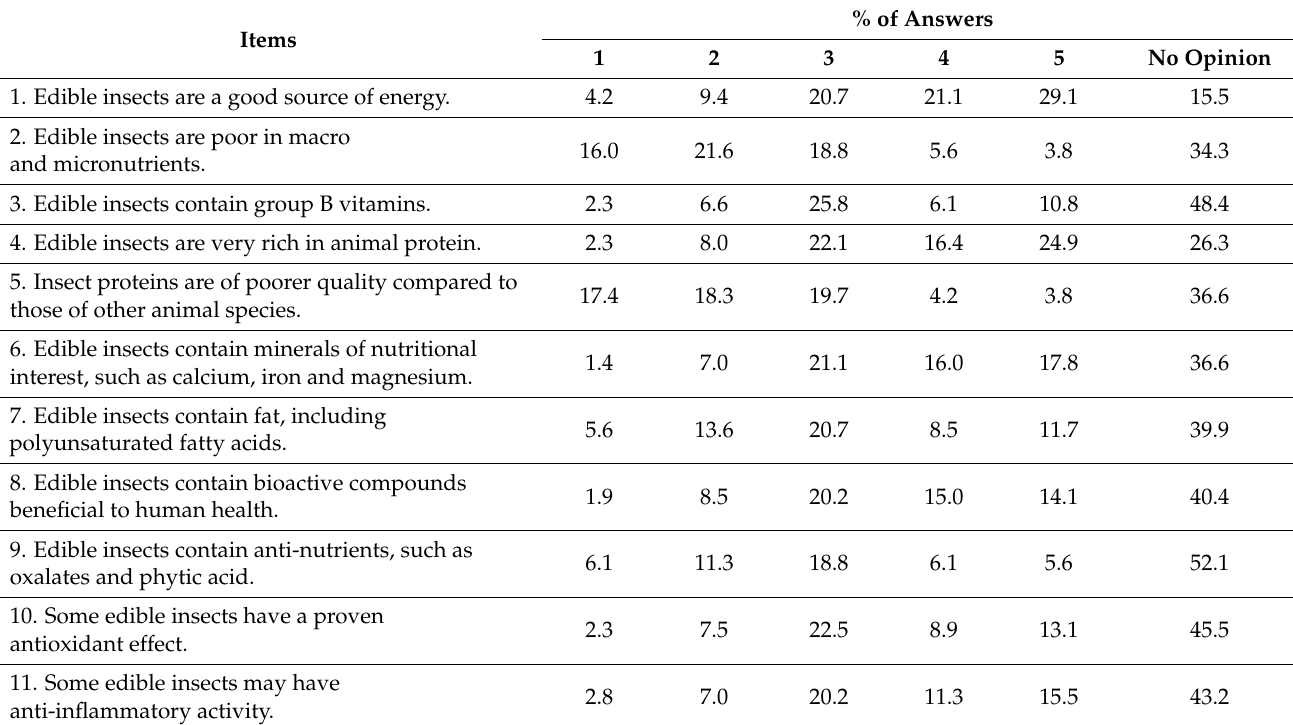
Table 6. Expressed opinions towards statements related with nutritive properties of EI (scale from 1 = totally disagree to 5 = totally